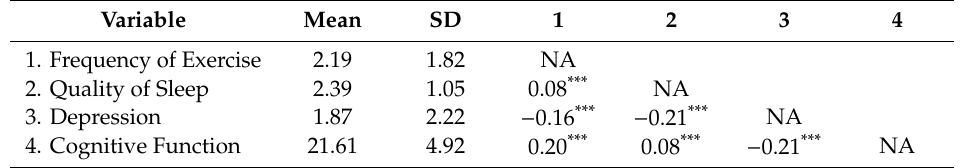
Table 1. Means (M), standard deviations (SD) and correlations among the